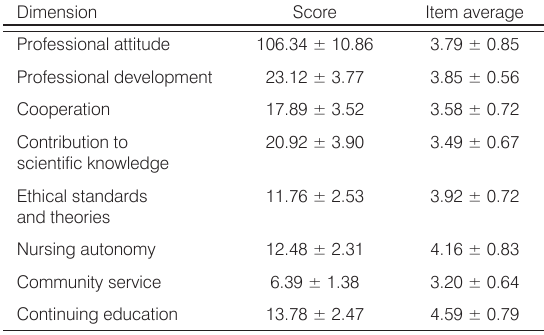
Table 1. The professional attitude scores of vocational nursing students ( N =656).